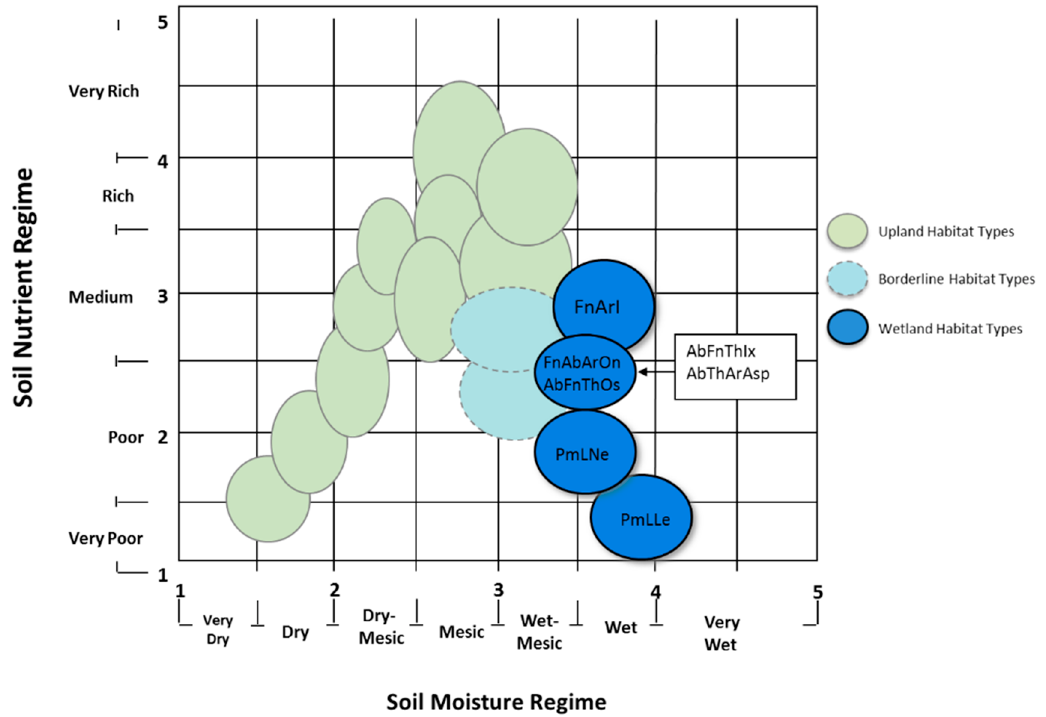
Figure 2. Synecological coordinates of forest habitat types in north-central Wisconsin (Region 3) based on understory plant species communities, soil moisture, and nutrient regimes. Habitat types in blue are recently added wetland habitat types, including several that are dominated by black ash: Fraxinus-Acer/Impatiens (FnArl), Fraxinus-Abies-Acer/Onoclea (FnAbArOn), Abies-Fraxinus-Thuja/Ilex (AbFnThIx), and Abies-Fraxius-Thuja/Osmunda (AbFnThOs). Black ash-dominated habitat types in general are most mesic in nutrient regimes relative to other forested wetland communities in the region. From Kotar and Burger [27].